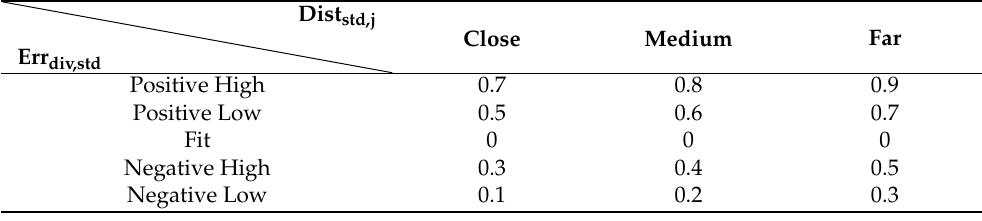
Table 3. The fuzzy rule base.